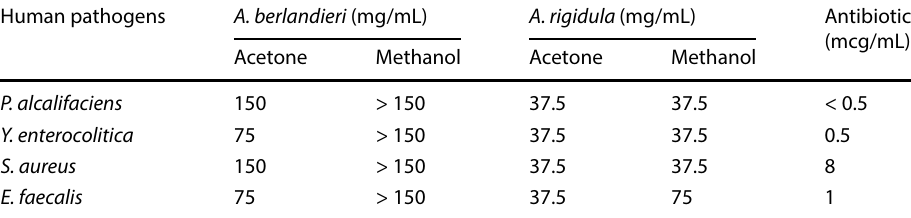
Results were consistent across three blocks, with each block consisting of three trials. MIC of A. berland- ieri methanol is greater than the initial 150 mg/mL concentration. Ciprofloxacin was used for P. alcalifa- ciens and Y. enterocolitica . Vancomycin was used for S. aureus and E. faecalis